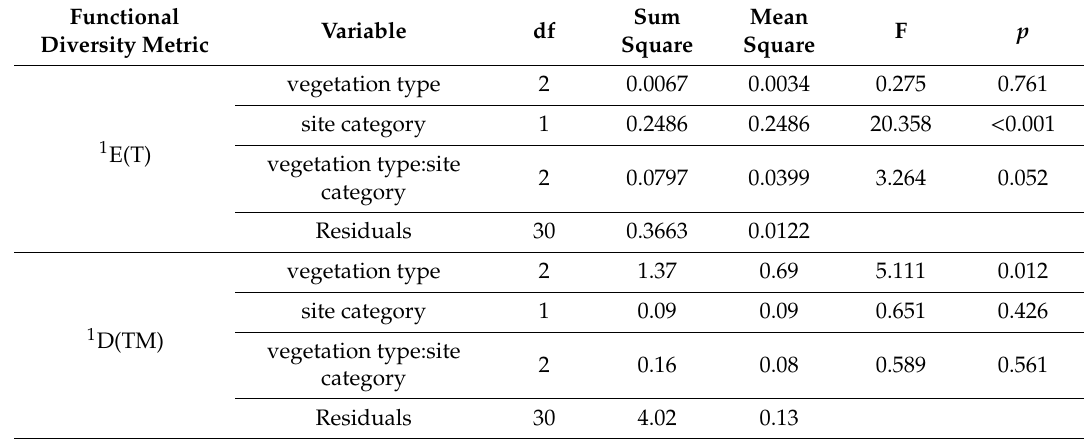
Table 5. Analysis of variance for functional diversity metrics. 1 E(T) = evenness of dispersion, 1 D(TM) = functional trait species